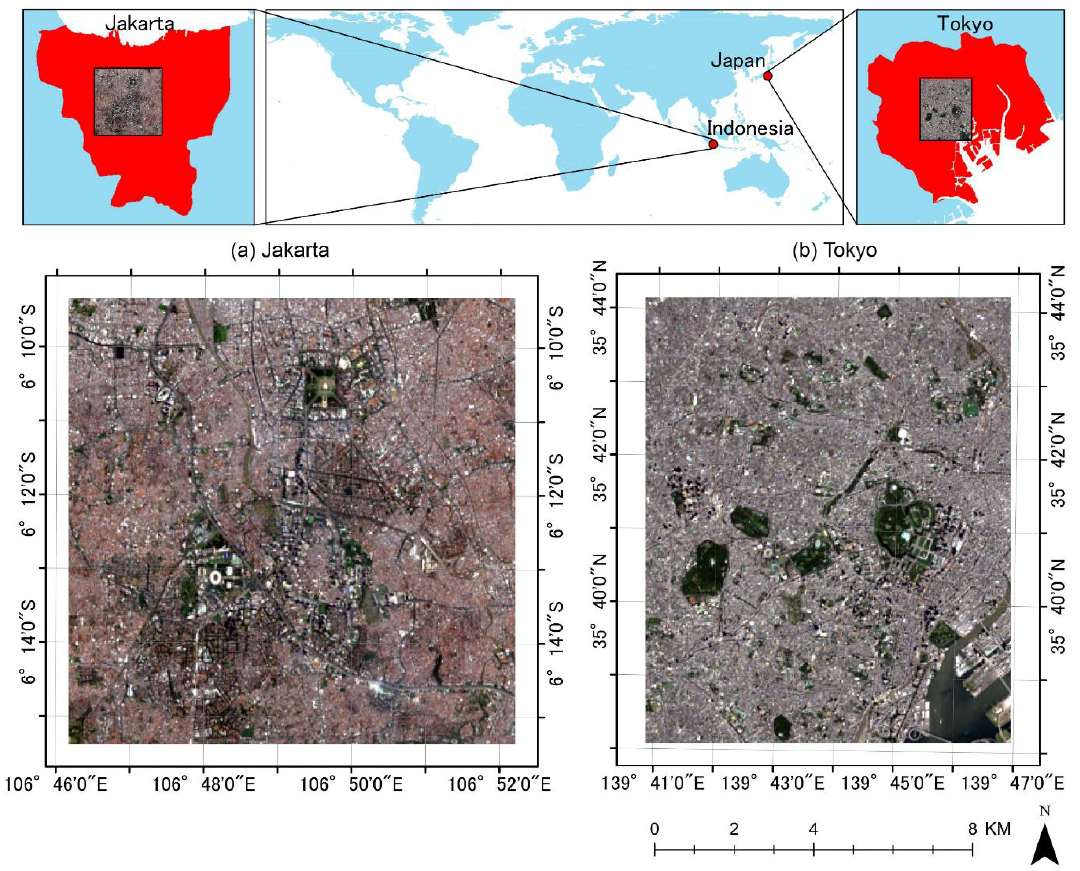
Figure 1. Study area: ( a ) Jakarta and ( b ) Tokyo. The coverage in each area is 0.1° × 0.1° longitude and latitude. The size is different in meters.